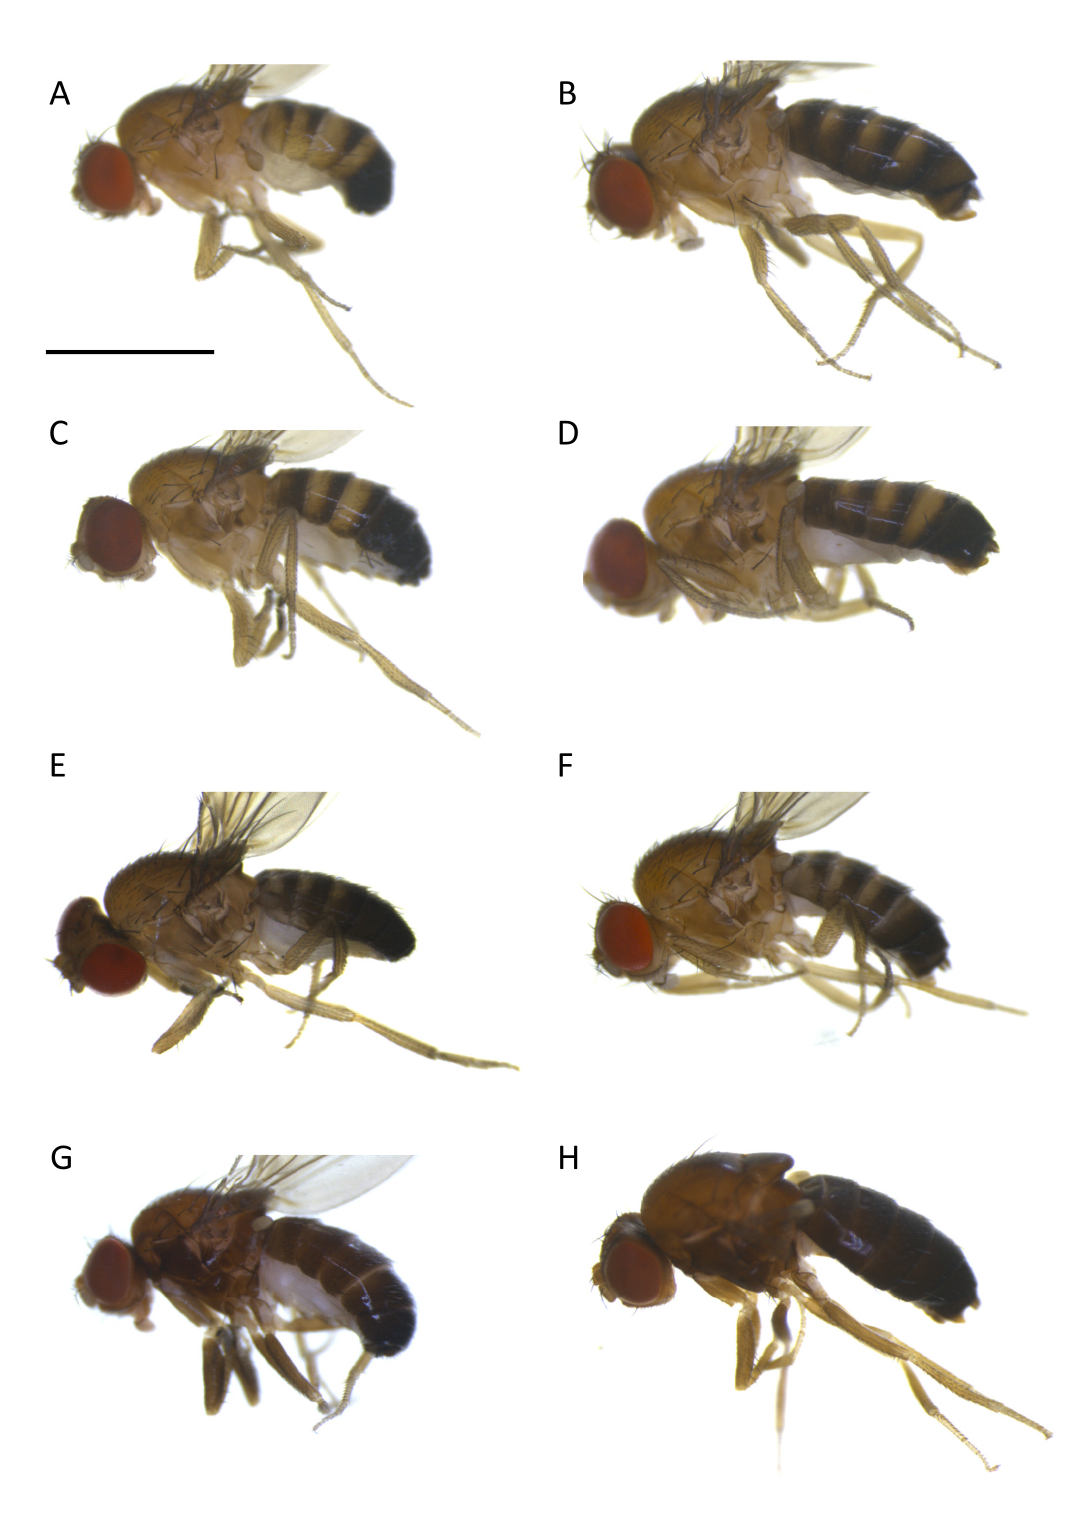
Fig. 4. Adult habitus. A – B . D. seguyi Smart, 1945 (MNHN). A . ♂. B . ♀. C – D . D. malagassya Tsacas & Rafael, 1982 (MNHN). C . ♂. D . ♀. E – F . D. curta Chassagnard & Tsacas, 1997 (MNHN). E . ♂. F . ♀. G – H . D. chocolata Yassin & David sp. nov. (MNHN). G . ♂. H . ♀. Only dark morphs of females of species with female-limited color dimorphism are shown. Scale bar = 1